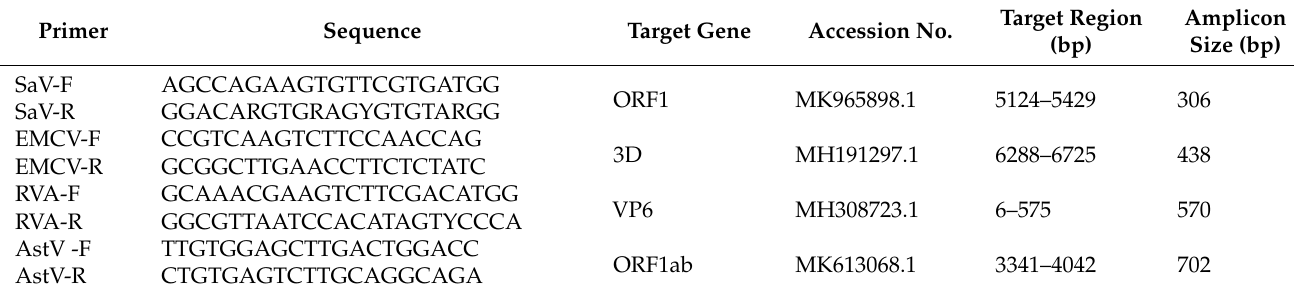
Table 1. List of primers used to detect SaV, EMCV, RVA and AstV by the mRT-PCR.